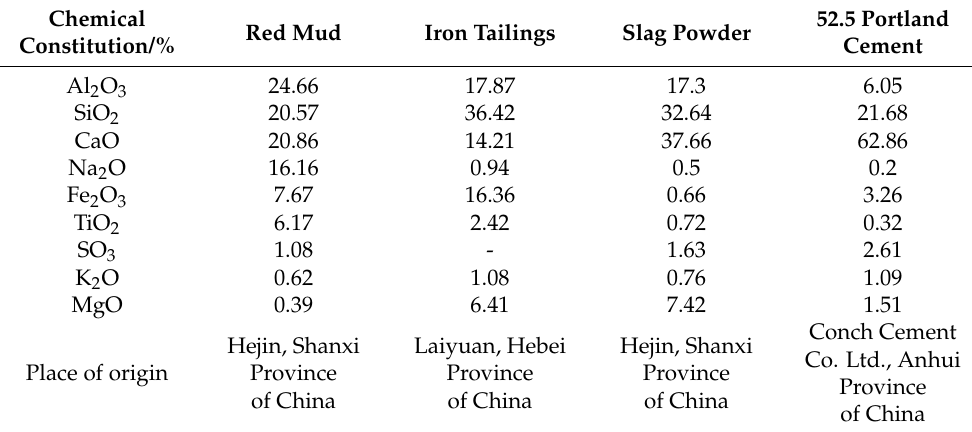
Table 1. Chemical composition and origin information of raw